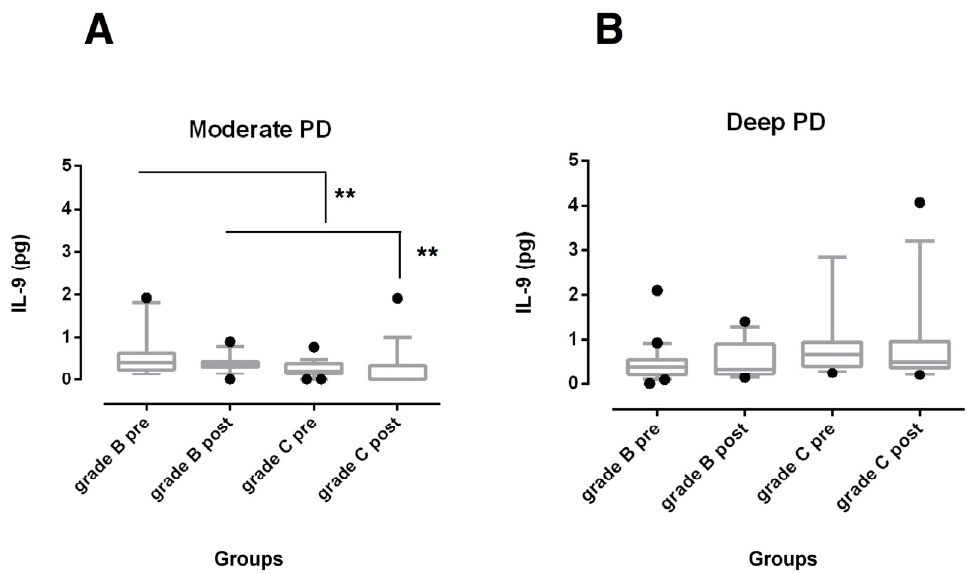
Figure 4. Box-and-whisker plots showing the total amount of IL-9 in gingival crevicular fluid of moderate ( A ) and deep pocket sites ( B ) in subjects with grade B and grade C stage III periodontitis before (pre) and after non-surgical periodontal therapy (post). Horizontal line represents the median with the box representing the 25th and 75th percentiles, and the whiskers denote the 5th and 95th percentiles. ** p < 0.01.